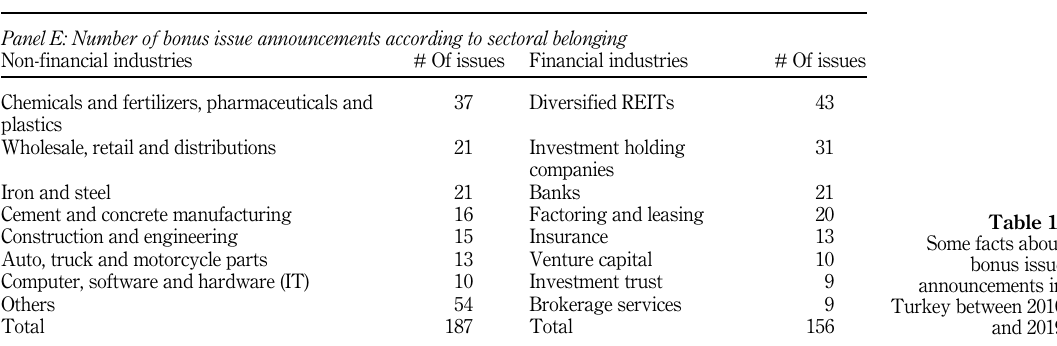
Panel E: Number of bonus issue announcements according to sectoral belonging Non-financial industries # Of issues Financial